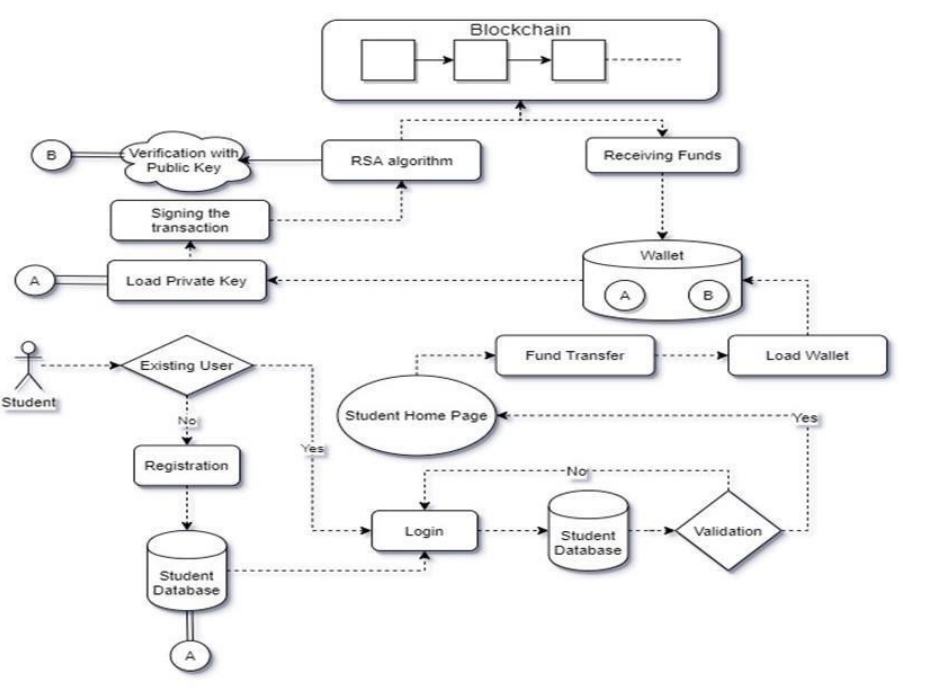
Figure 6. Private Cryptocurrency